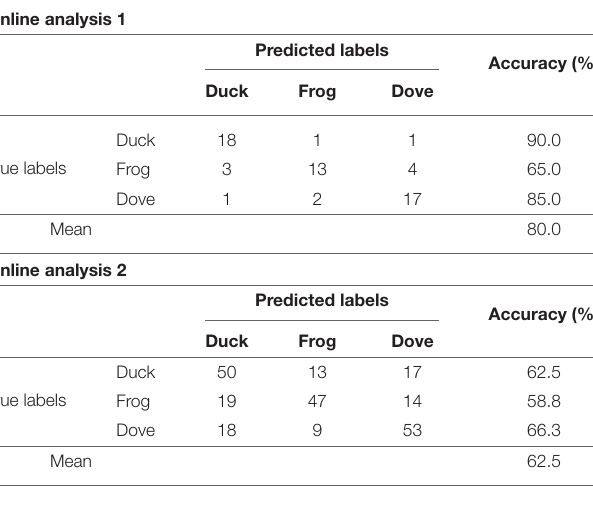
TABLE 5 | Confusion matrix of three sound labels over all subjects in online